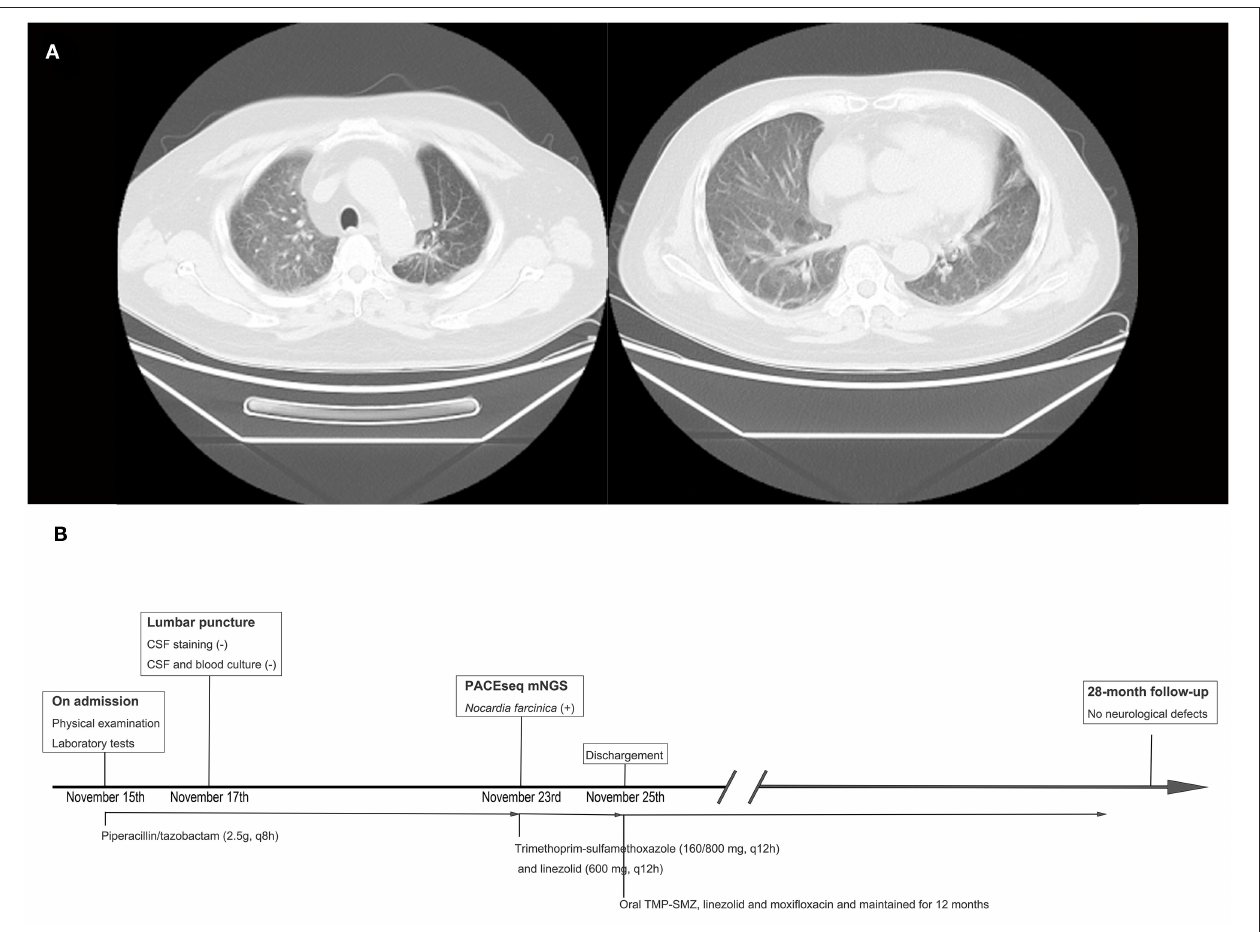
FIGURE 2 | Thoracic computed tomography (CT) scan results and timeline of the treatment. (A) Thoracic CT scan showing chronic interstitial inflammation and localized emphysema of the left upper lung. (B) Timeline of the treatment of this case.